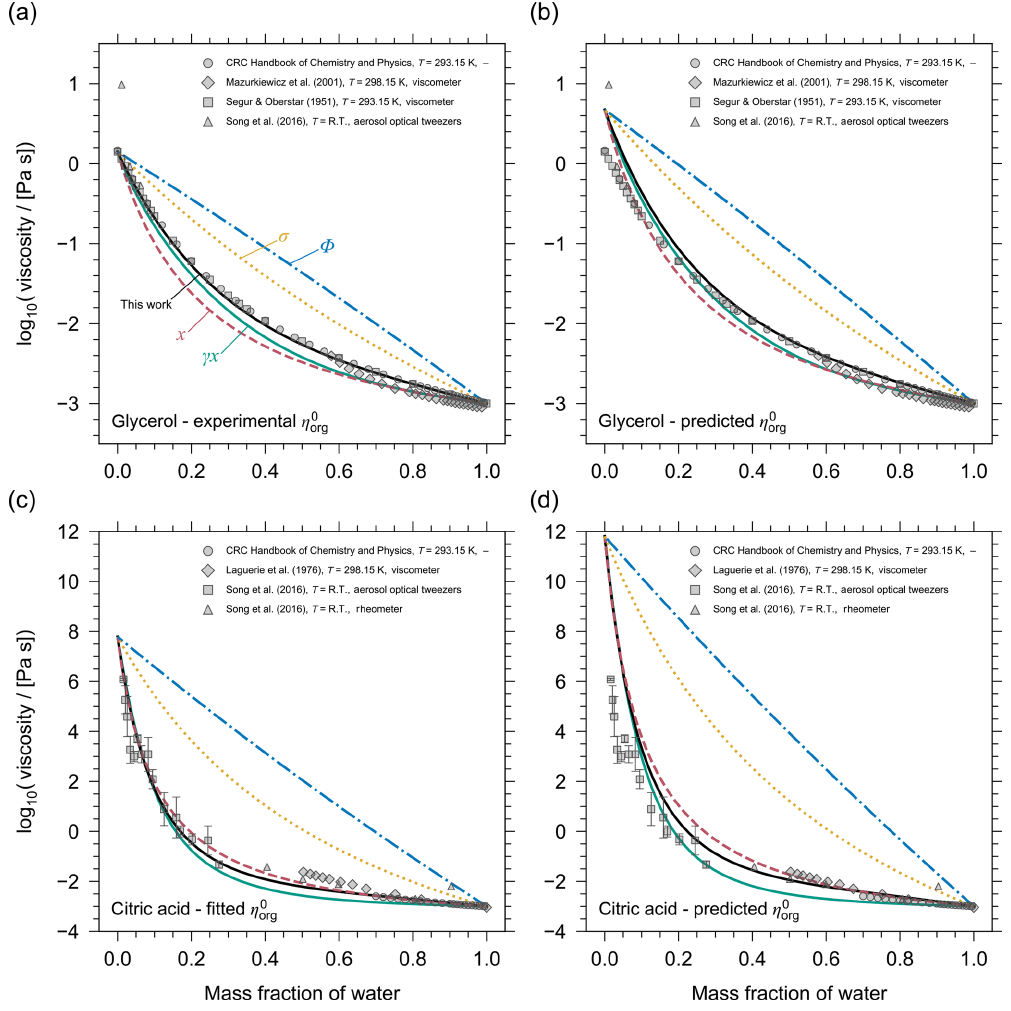
Figure 4. Model intercomparison of mixture viscosity predictions as a function of mass fraction of water at T = 293 . 15K. The mixing models shown are AIOMFAC-VISC (black solid lines) and four simple viscosity mixing rules (Eq. 14): molecular mole-fraction-weighted (pink dashed lines), volume-fraction-weighted (blue dash-dotted lines), surface-area-fraction-weighted (yellow dotted lines), and mole-fraction- based activity-weighted (green solid lines) means of pure-component viscosities. Top row: the binary mixture of glycerol and water, with the pure-component viscosity of glycerol assigned from (a) the measured value or (b) predicted by the DeRieux et al. (2018) method. Bottom row: the binary mixture of citric acid and water, with the pure-component viscosity of citric acid assigned (c) based on an AIOMFAC-VISC fit of η 0 org using the shown experimental data or (d) predicted by the DeRieux et al. (2018) method. Grey markers show experimental data from different methods (see